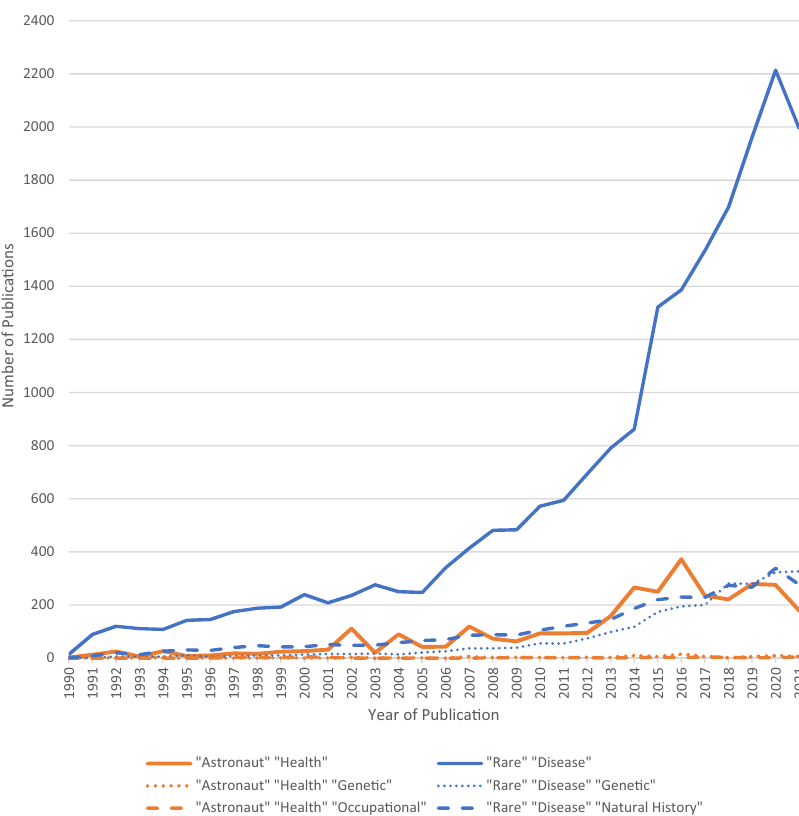
Fig. 1 Number of publications for rare disease and space health through time. Rare disease, despite being individually rare collectively affect a signi fi cant proportion of the population and thus elicit a higher research output than space health. Even with the revolutions in genomics, genetic studies in astronauts remain rare. Despite commonality of genetic basis for rare disease, genetic studies have increased in the fi eld of rare diseases but they do not represent a dominant research topic in the scienti fi c literature nor even, surprisingly, a growing proportion of the scienti fi c literature. Consideration of “ natural history ” seems mostly absent from the space health literature but appears as often as genetic in the rare disease literature. The number of annual publications for the keywords “ rare disease ” (blue) and “ astronaut ” + “ health ” (orange) from 1990 to present day (2021). Data was additionally generated for keyword combinations such as “ rare disease ” and “ natural history ” (green), “ genetic ” and “ astronaut ” + “ health ” (yellow), and “ genetic ” and “ rare disease ” (red). No publications were found for the “ astronaut ” + “ health ” and “ natural history ” . All data was generated using Web of Science. Data in Source data